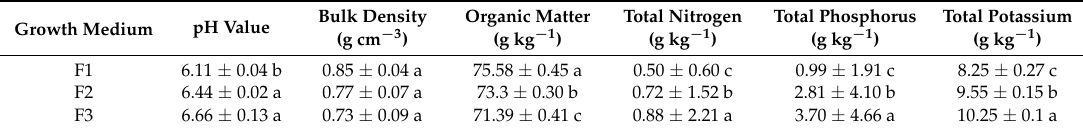
Table 1. The physical and chemical properties of three growth